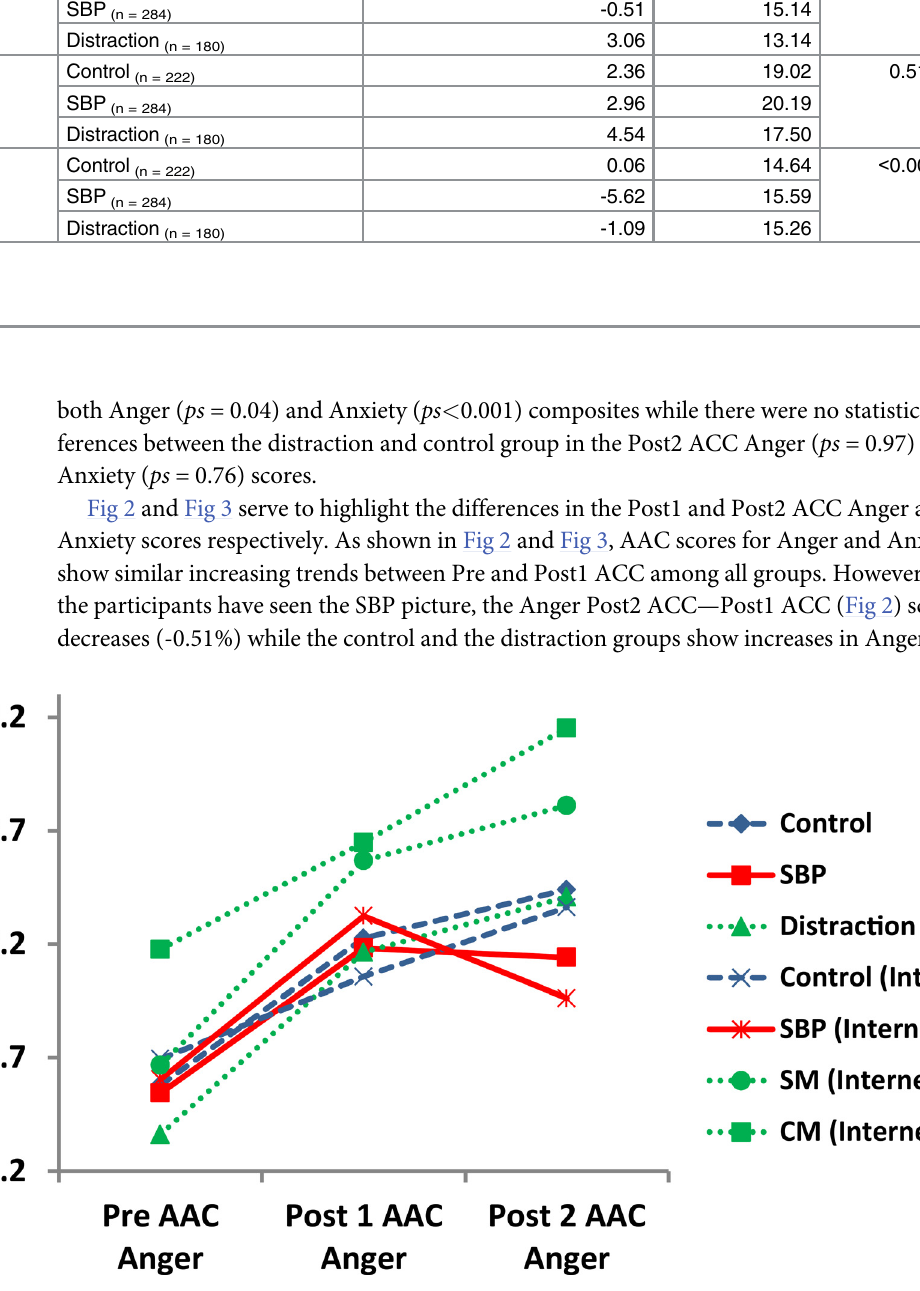
Fig 2. Mean scores for the Anger AAC composite between experimental groups. SBP: Secure Base Prime, SM: ” Smiling Man ” , CM: ” Cold Mother and Child ”